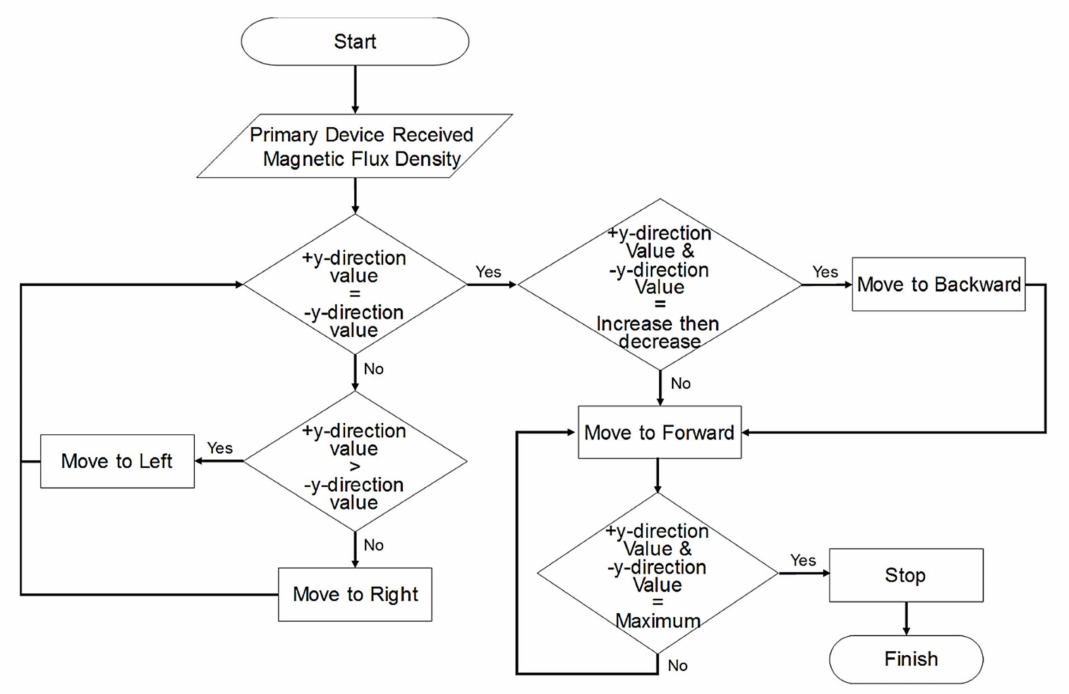
Figure 16. Sequence for finding the center alignment